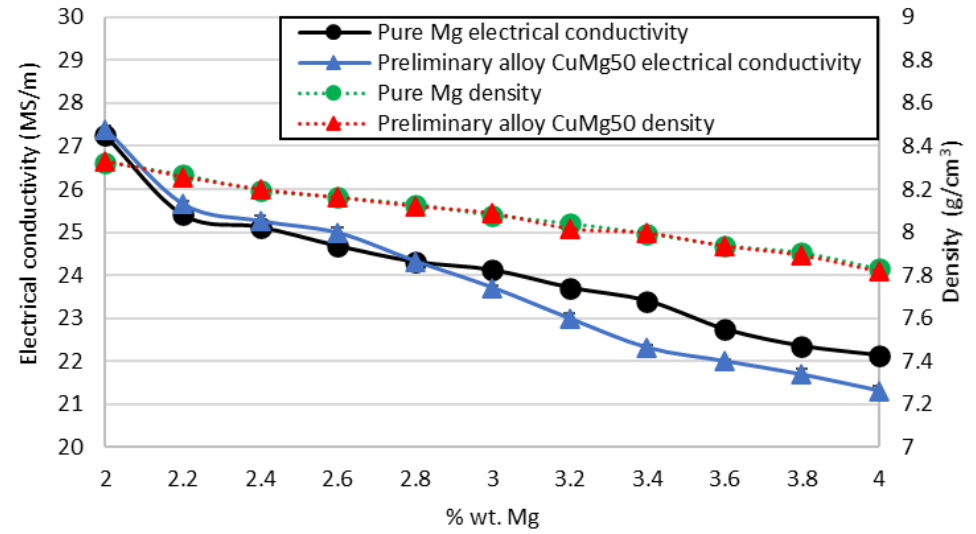
Figure 3. Average values of electrical conductivity and density of the tested materials; electrical conductivity marked with a full line; density marked with a dotted line; pure Mg marked with circles; preliminary alloy CuMg50 marked with triangles.